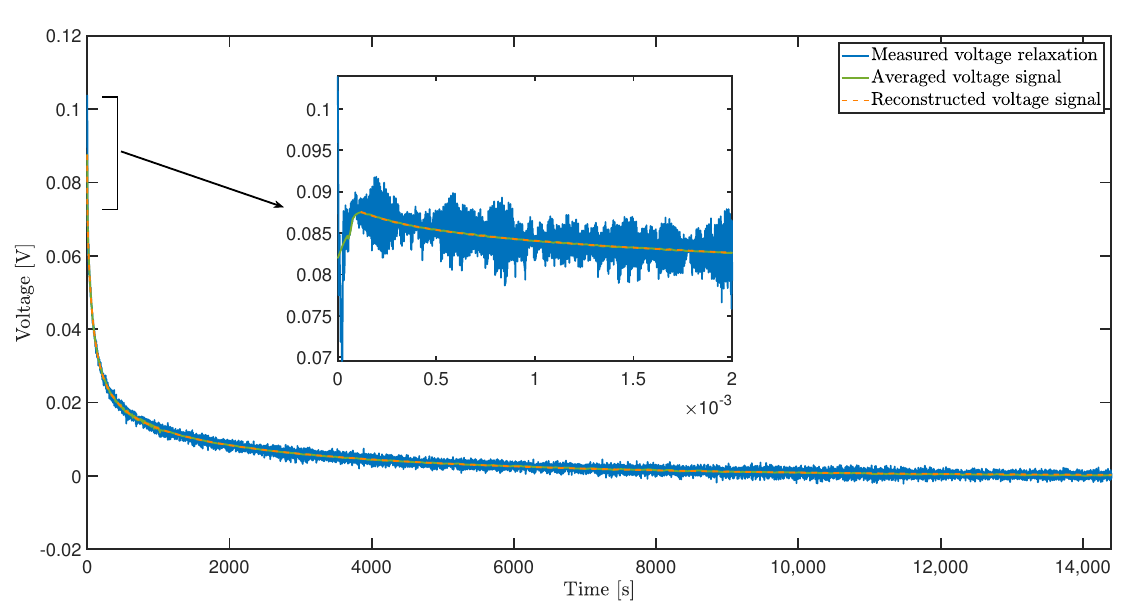
Figure 4. Pulse test: Voltage relaxation at 20% SOC.